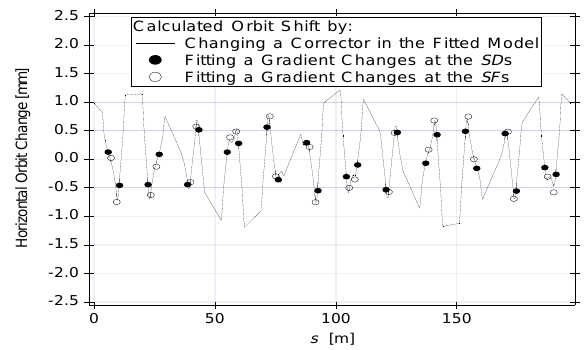
FIG. 6. Comparison of two methods for determining an orbit change in the ALS when one corrector is changed. Method 1 (solid line): Use the fitted model of the ring and the fitted gain of the corrector to calculate the orbit shift. Method 2 (circles): Use the calculated orbit change from the difference in the quadrupole gradients in the sextupoles.